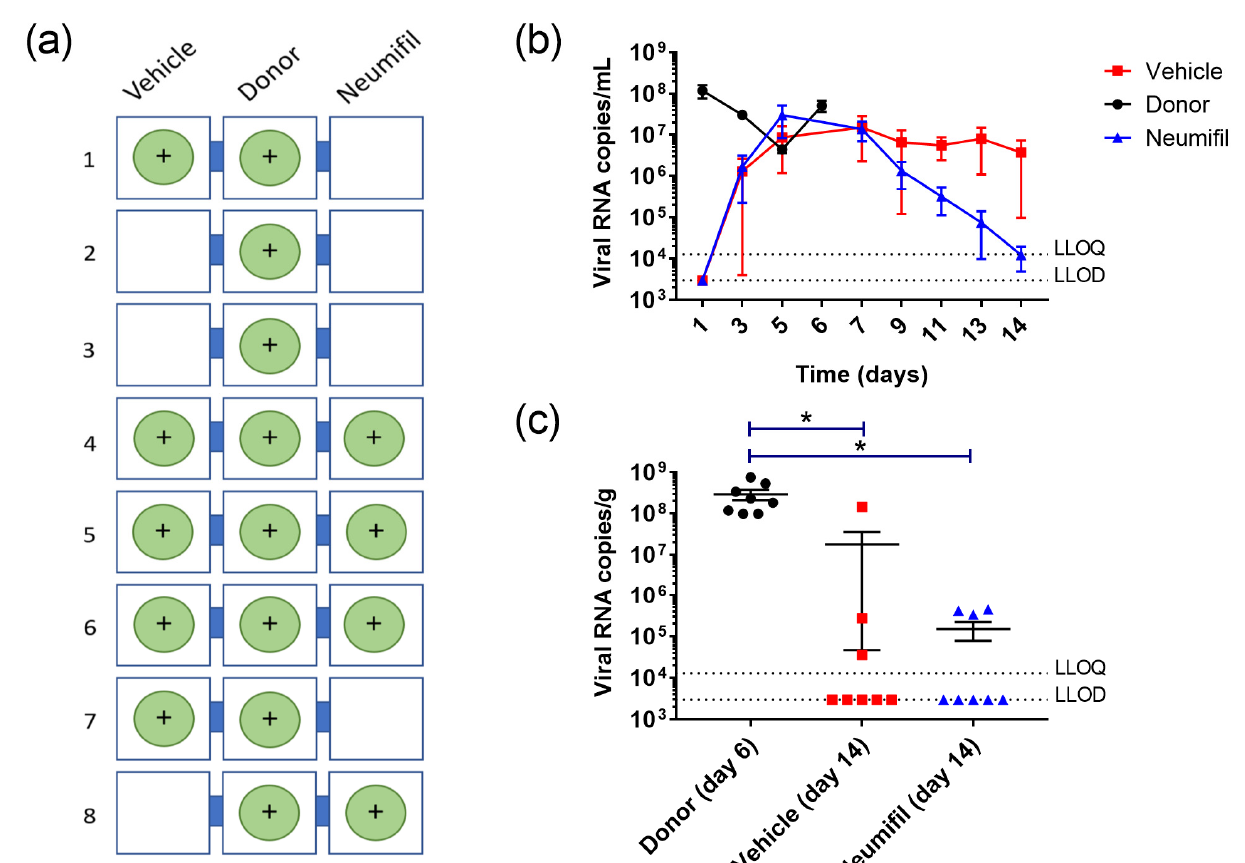
Figure 3. Viral RNA transmission and kinetics in donor animals and recipient animals receiving either Neumifil or vehicle. ( a ) Diagrammatic view of cages identifying the location of animals with PCR positive throat swab samples. ( b ) Levels of viral RNA detected in throat swabs. Symbols represent mean value, with error bars denoting standard error. No statistical significance was observed.